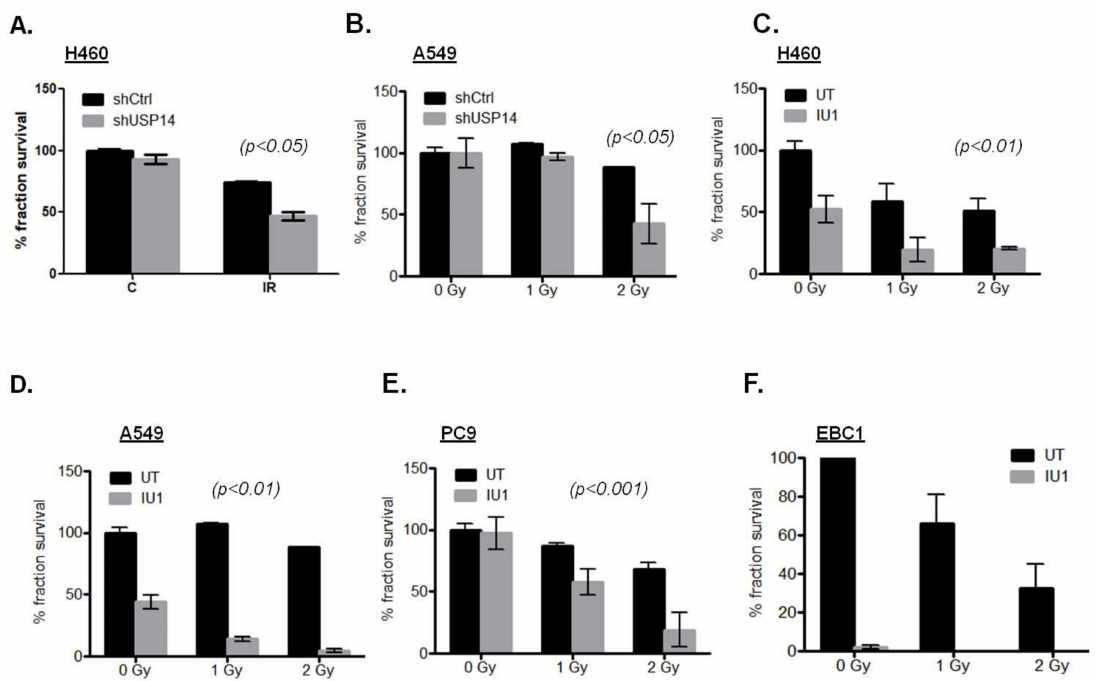
Figure 3. Targeting USP14 causes radiosensitization in NSCLC cells. Clonogenic cell survival analyses in shControl (shCtrl)- vs. shUSP14-expressing ( A ) H460 and ( B ) A549 cells treated with the indicated doses of IR. Clonogenic survival analyses in ( C ) H460, ( D ) A549, ( E ) PC9, and ( F ) EBC1 cells pretreated with 50 µ M IU1 for 1 h +/ − indicated doses of IR compared to those untreated (UT). Data shown are the means ± SEM ( n =